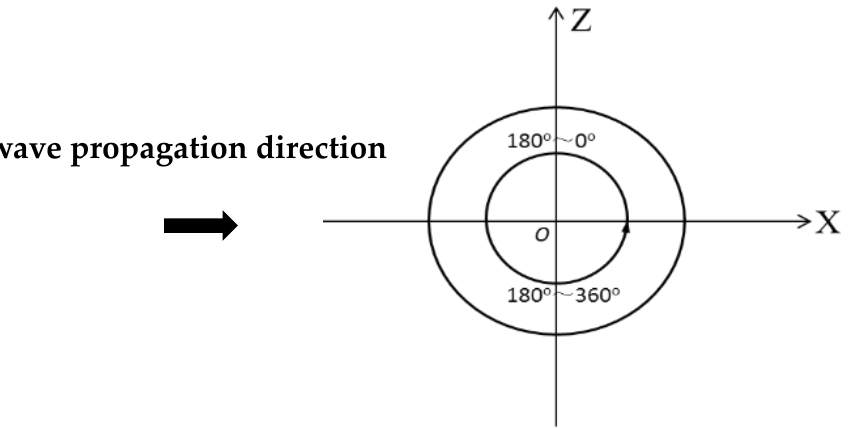
Figure 9. Schematic diagram for the definition of circumferential angle.